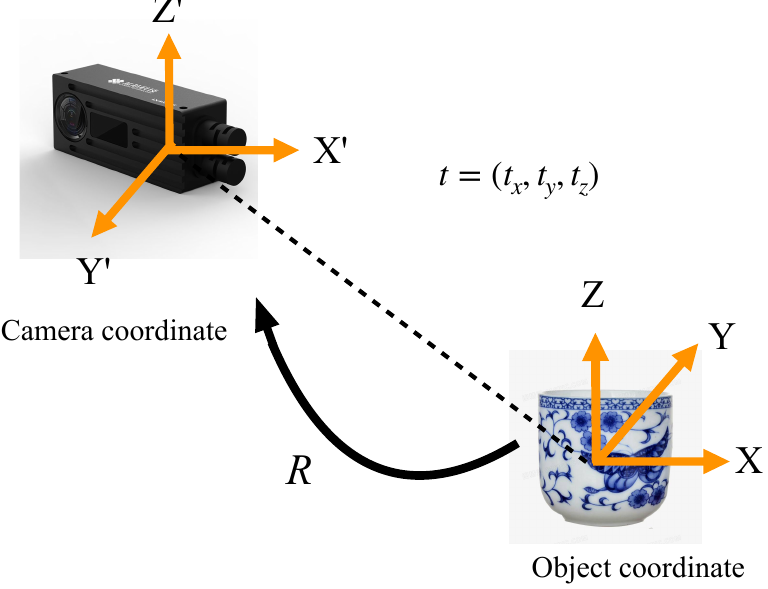
Figure 7. Illustration of object 6D pose estimation. The pose transformation matrix between the object coordinate system and the camera coordinate system is composed of the rotation matrix R and the translation vector t